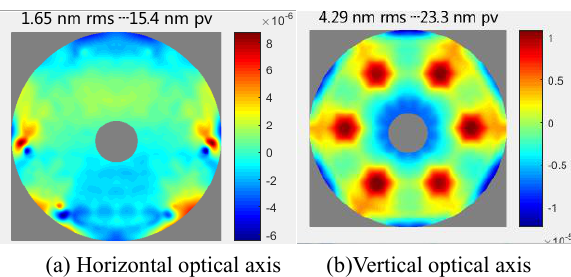
Figure 14 Modal analysis in optical axis